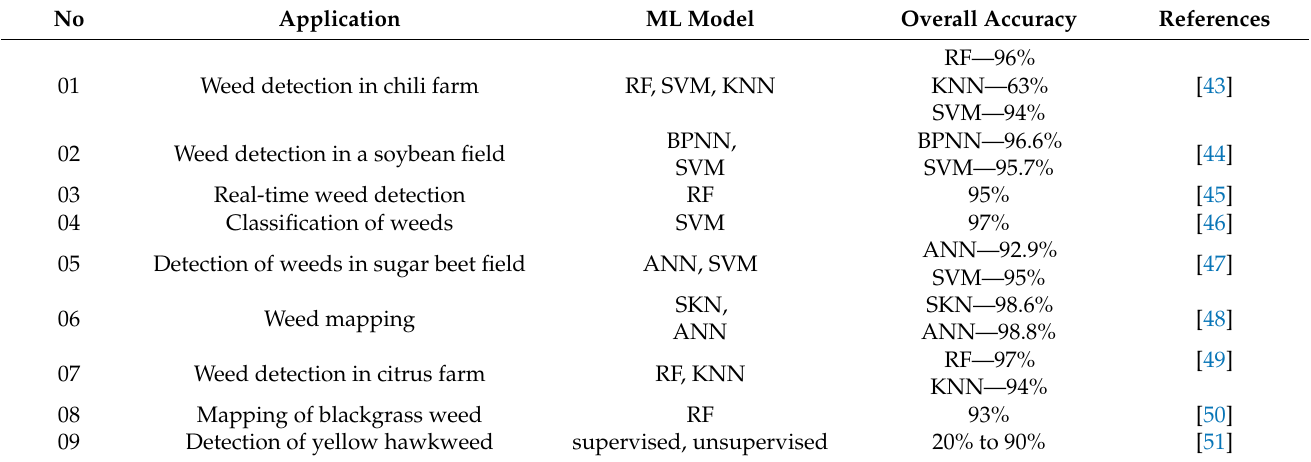
Table 1. Application of machine learning techniques for weed